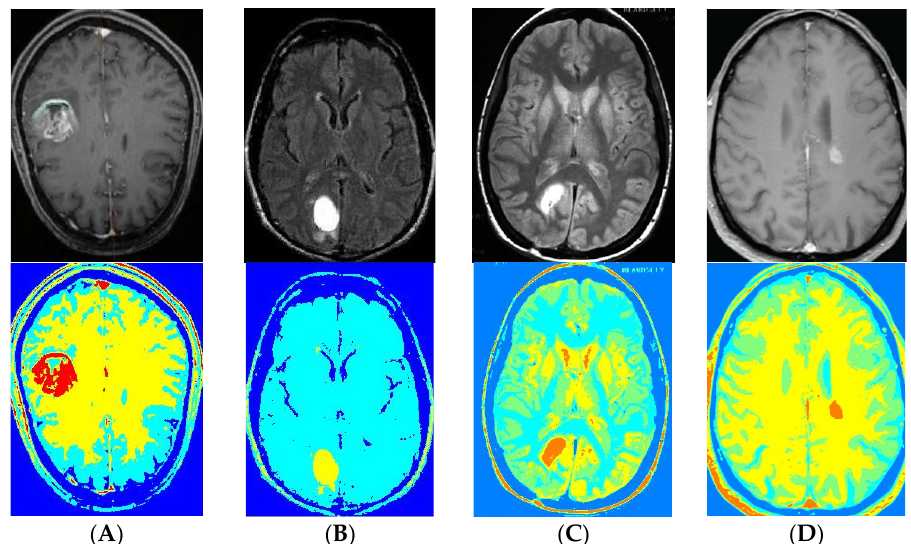
Figure 3. Color segmentation findings using the multilevel threshold method applied to three grey levels of images. ( A ) the red is primarily representing the tumor. ( B ) yellow is primarily representing the tumor; ( C ) the orange color represents the segmented tumor. ( D ) the orange represents the suspected tumor.